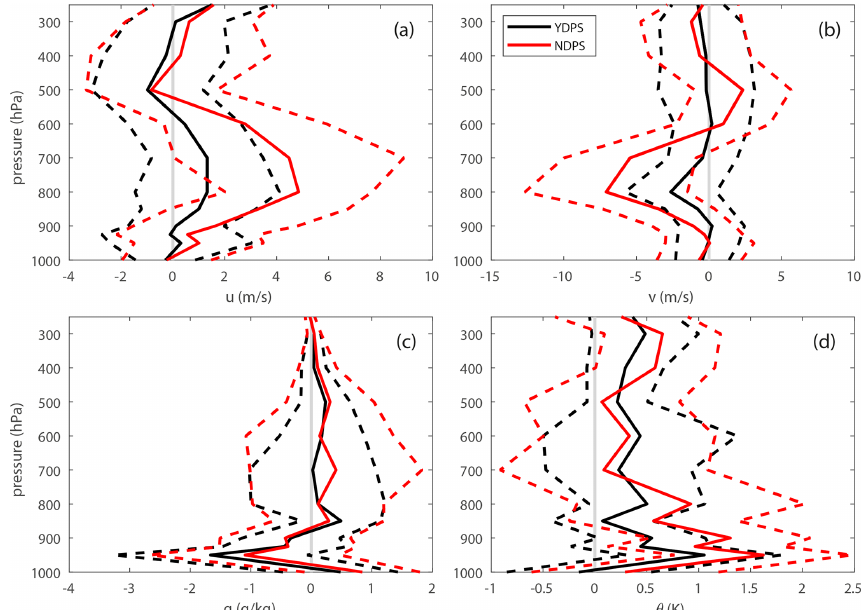
Figure 6. Similar to Fig. 5 but for the special case in box